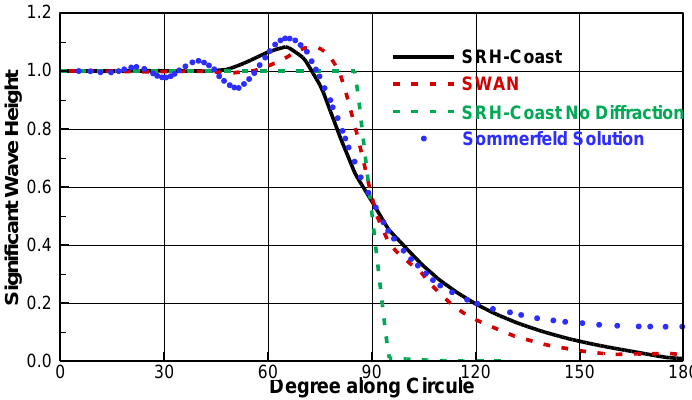
Figure 13. Comparison of the significant wave height among the SRH-Coast solution, analytical solution of Sommerfeld and SWAN solution along the 3L semi-circle.